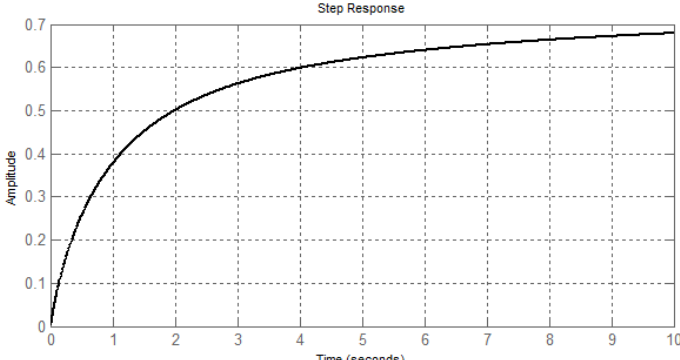
p j − ω 4 π Figure 3. Vector displacement for the first two complex-conjugate roots for the case when 𝜔 𝜖 (0, ∞) . Example.